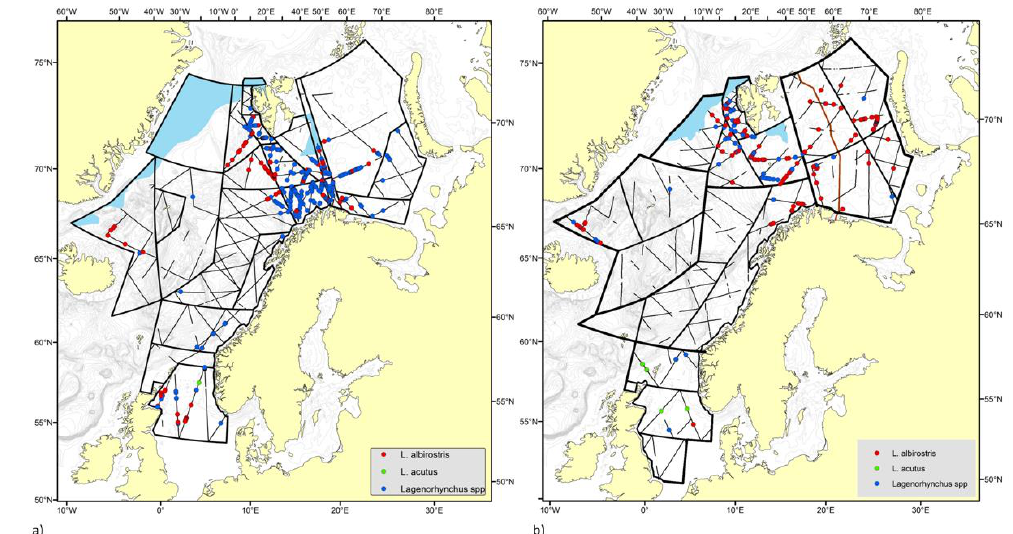
Figure 12. Distributions of sightings recorded as Lagenorhynchus spp. during (a) the 2002 – 2007 surveys and (b) the 2008 – 2013 surveys. The blue areas represent ice coverage.